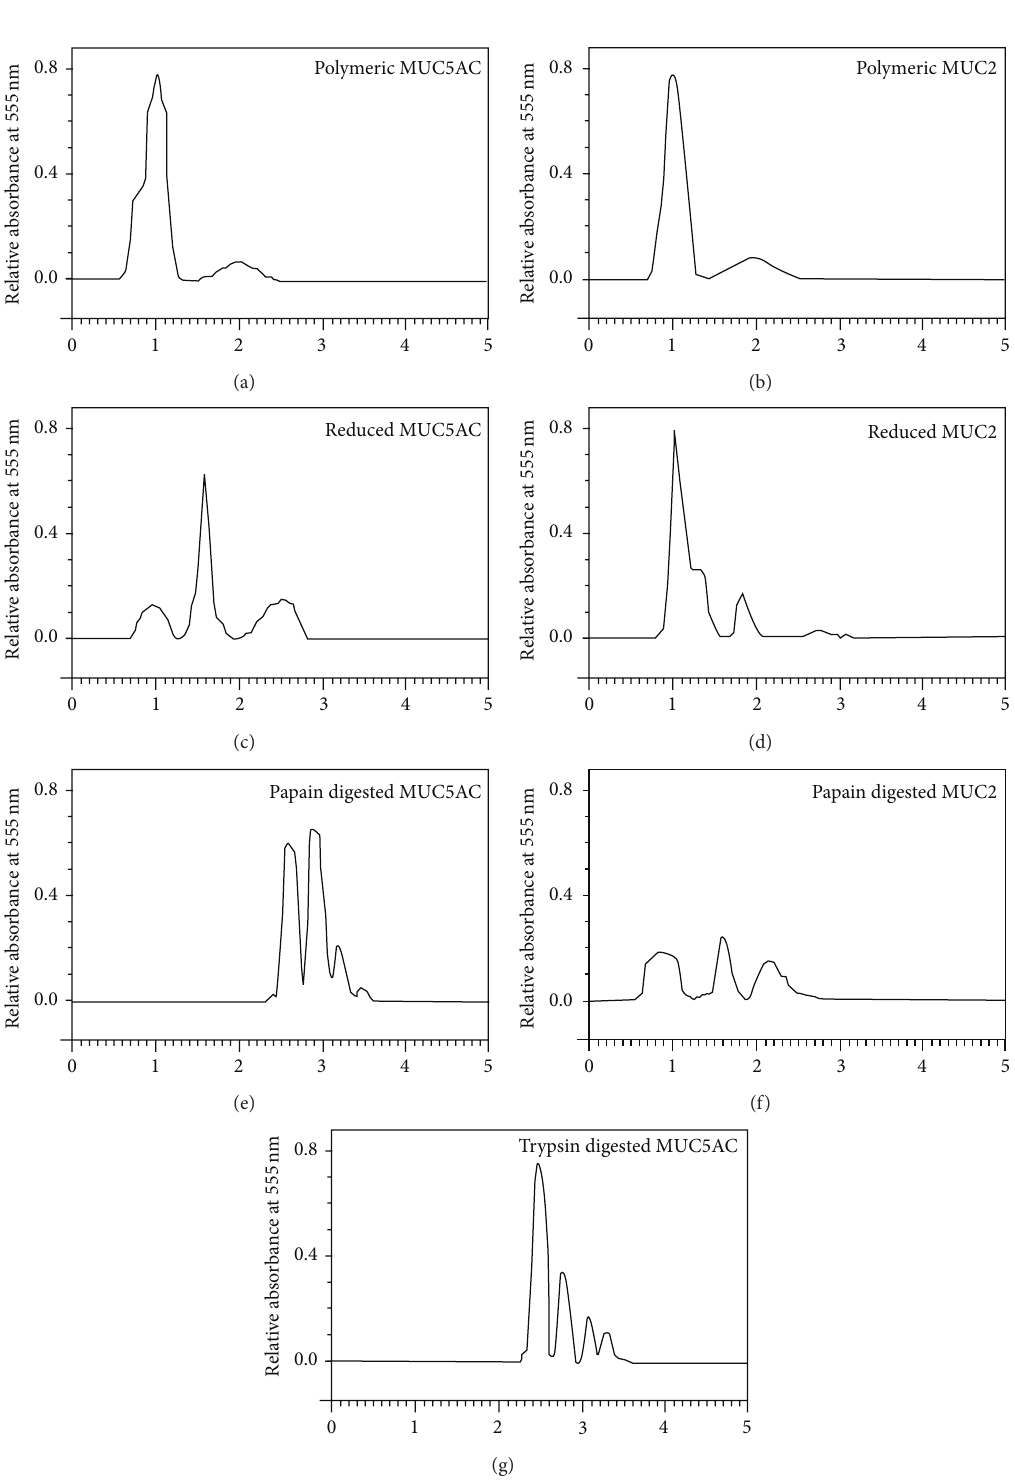
Figure 2: Densitometric scans of SDS-PAGE of polymeric and fragmented MUC5AC and MUC2 rich sinus mucins. The 𝑥 -axis represents the localization of the different PAS-positive peaks relative to the site of application on the stacking gel (1) and the interface between the stacking and migration gel phases (2). The 𝑦 -axis represents the relative absorbance of the different PAS-positive material (mucins) measured in arbitrary units. For the purpose of comparison of the different electrophoretic patterns, the presented figures were arranged as follows: ((a), (c), (e), and (g)) polymeric, reduced, papain digested, and trypsin digested MUC5AC rich mucins, respectively; ((b), (d), and (f)) polymeric, reduced, and papain digested MUC2 rich mucins,